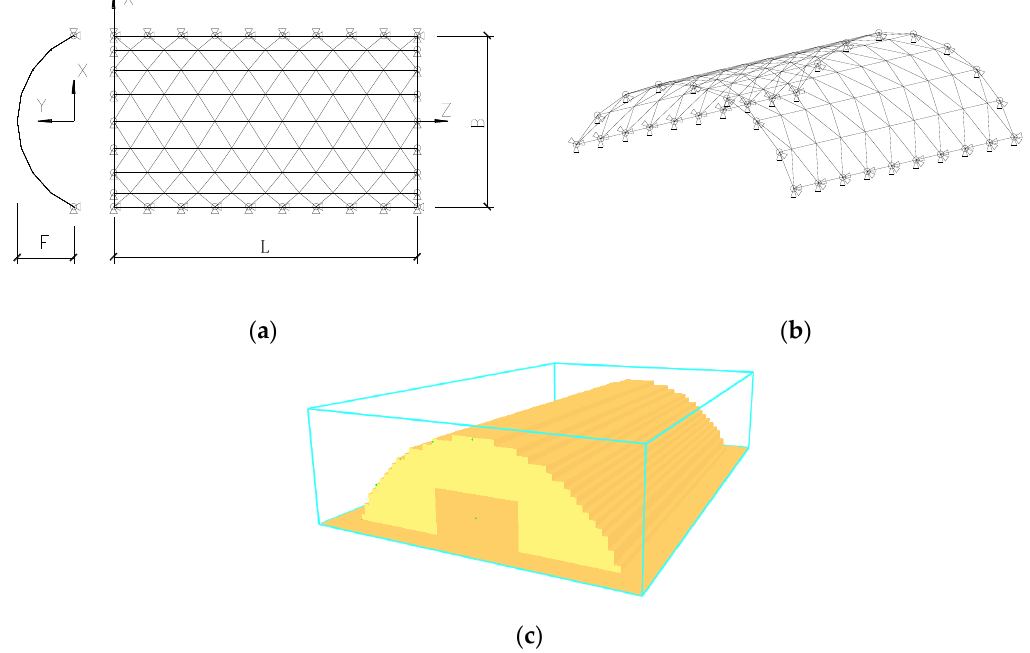
Figure 1. Analysis model of three-way, gridded, single-layer, cylindrical latticed shell. ( a ) Plan view of the analysis model; ( b ) three-dimensional (3D) view of the analysis model; ( c ) the analysis model in FDS.